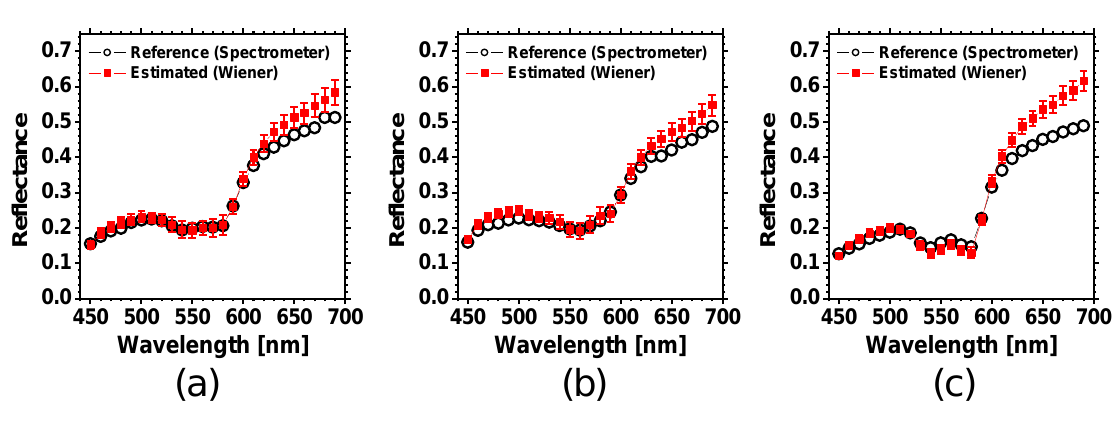
Table 1. The goodness-of-fit coefficient (GFC) obtained from the 5